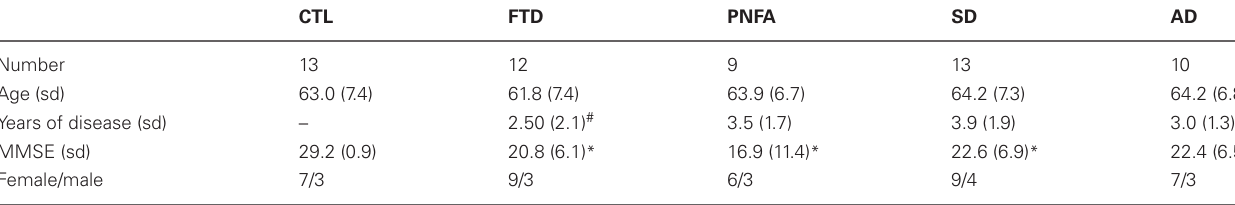
Table 1 | Demographic and neuropsychological characteristics of the investigated